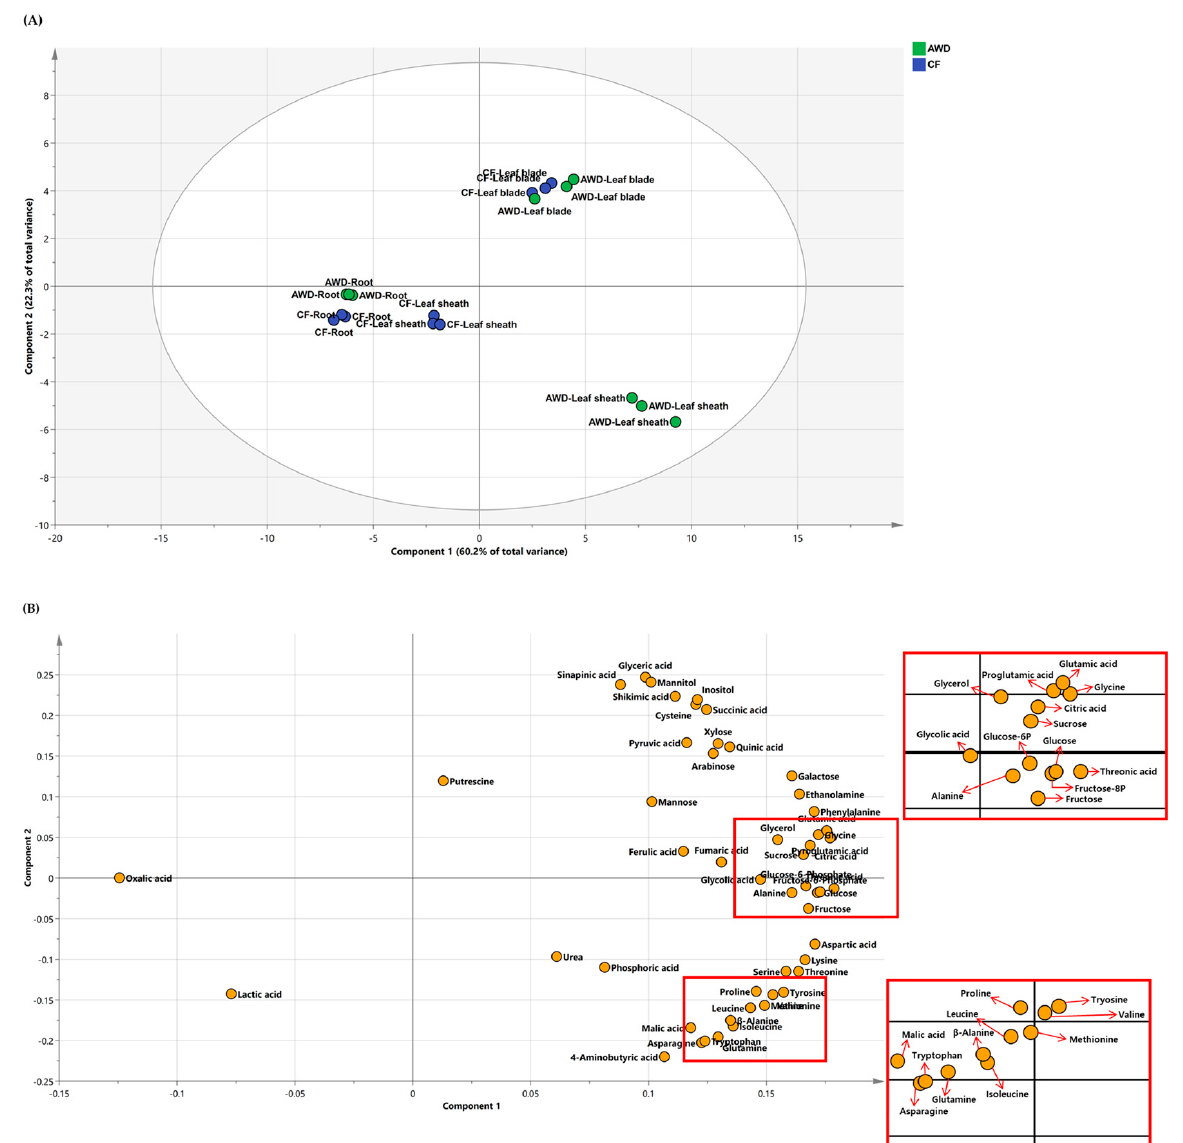
Figure 2. Principal component analysis (PCA) score ( A ) and loading ( B ) plots of metabolites identified from leaf blades, leaf sheaths, and roots of rice plants at heading stage.